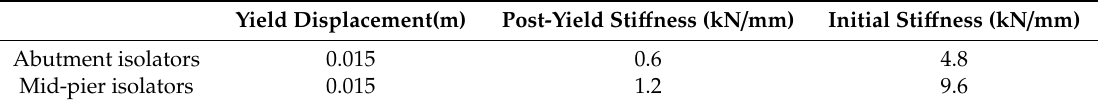
Table 3. LRB characteristics of the benchmark bridge.